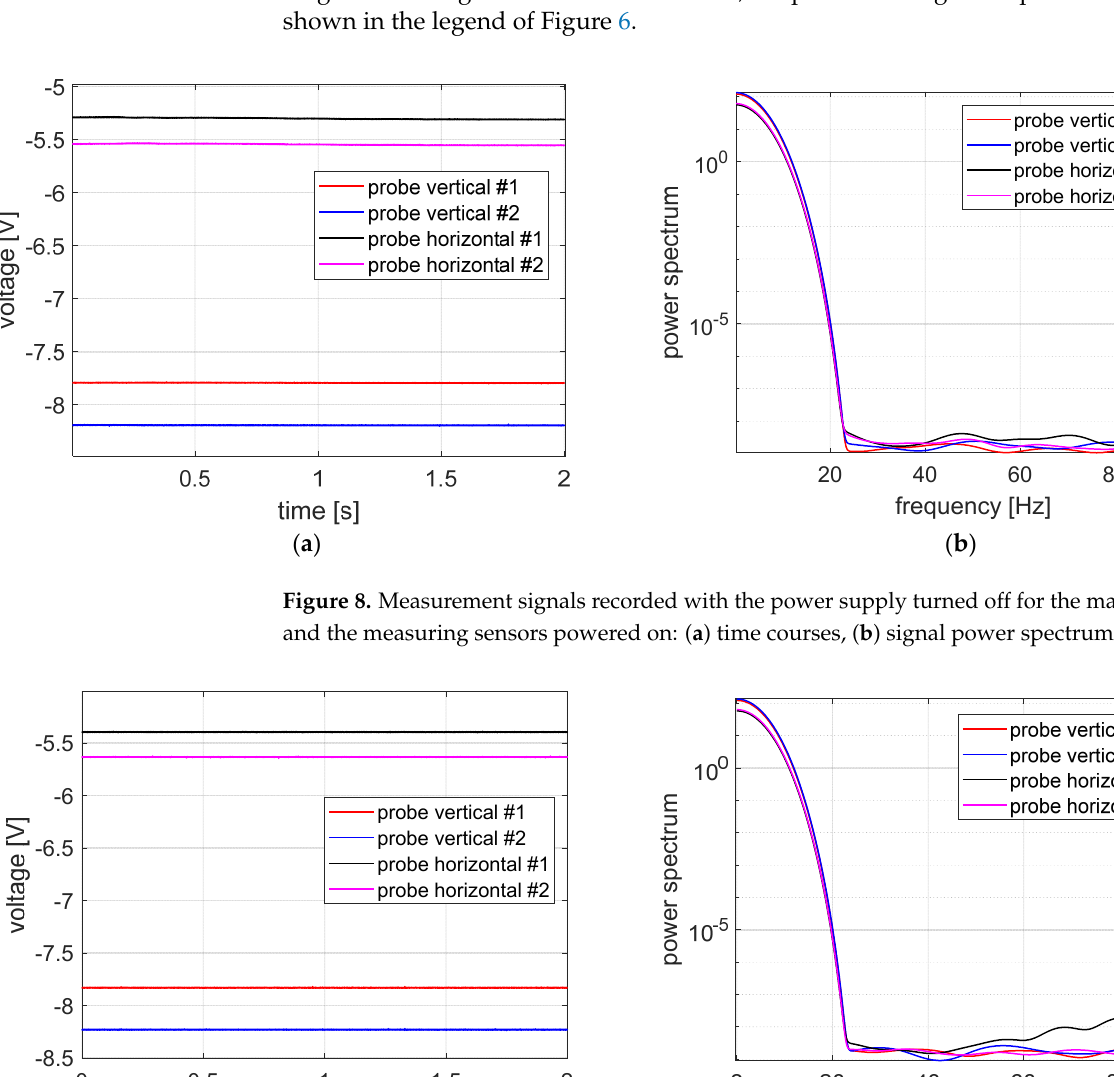
Figure 7. Measurement signals recorded with the power supply turned off for both the magnetic bearings and measuring sensors: ( a ) time courses, ( b ) signal power spectrum.